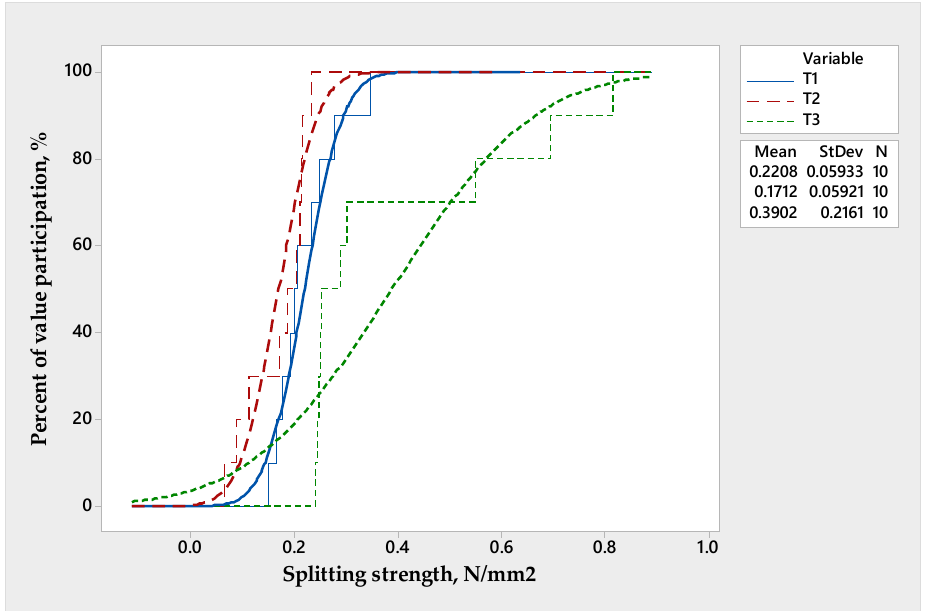
Figure 4. Empirical Cumulative Distribution Function (CDF) for splitting strength of briquettes: T1 briquettes without voids with a diameter of 59 mm; T2 briquettes without voids with a diameter of 71 mm; T3 briquettes with inner hollows.